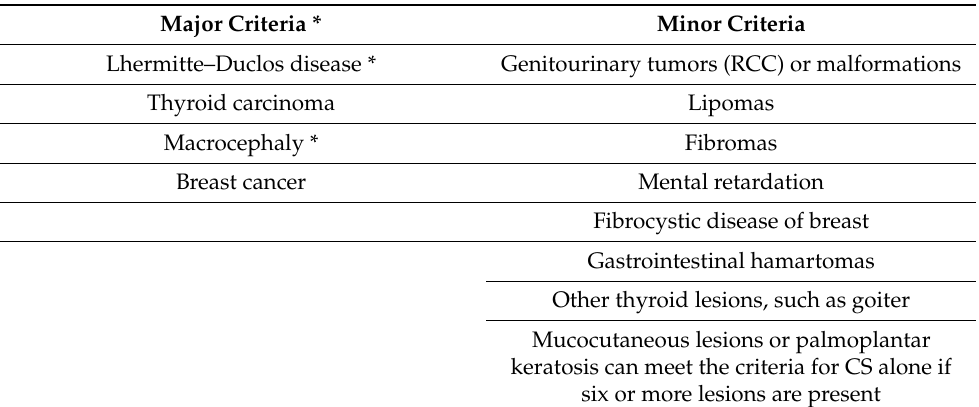
Table 1. Major and minor diagnostic criteria established by the International Cowden Syndrome Consortium for the diagnosis of Cowden